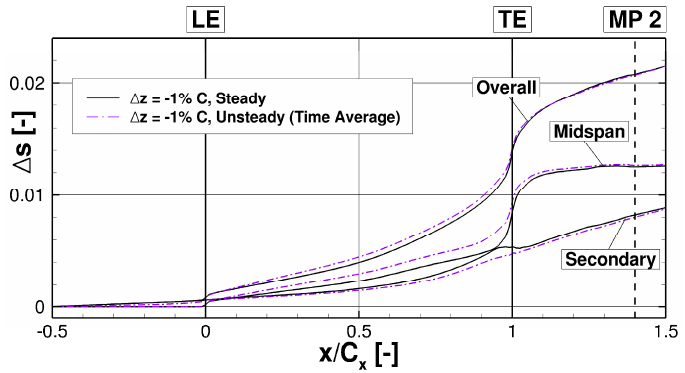
Figure 24. Axial entropy development throughout the T106A blade passage with steady and unsteady inflow conditions.